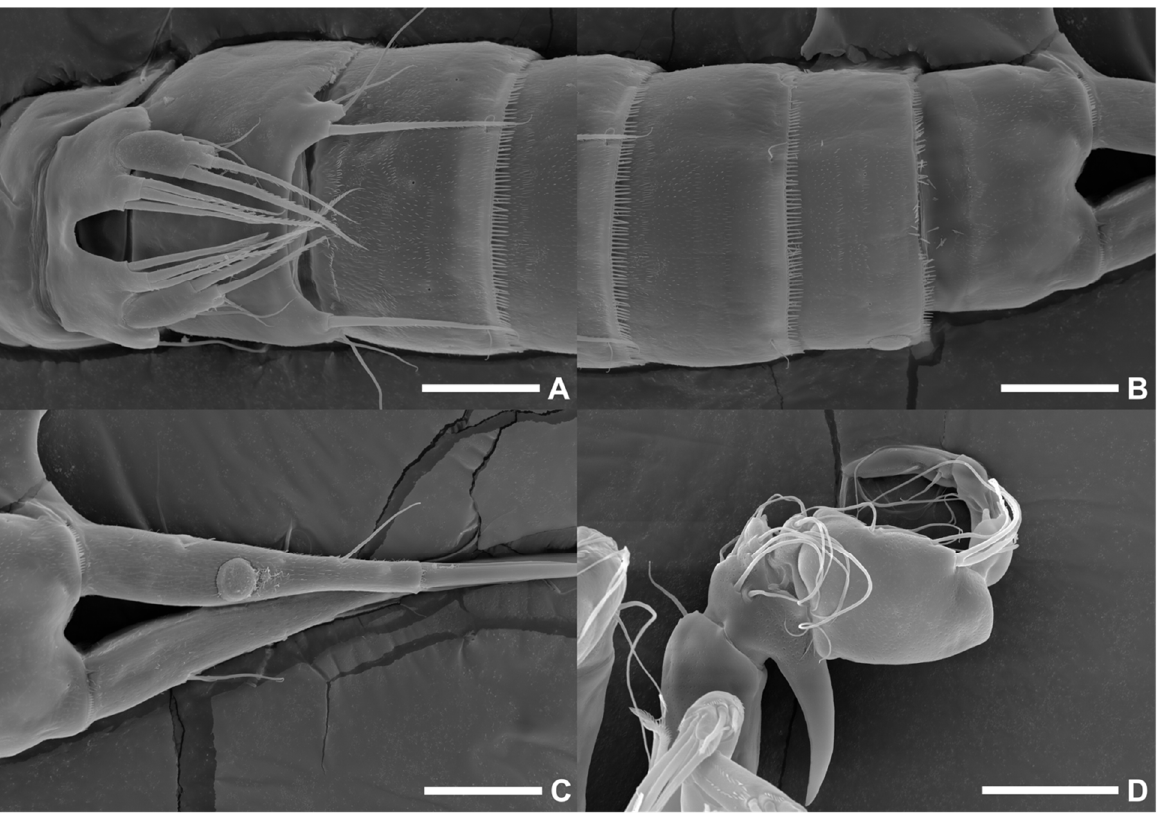
Figure 16. Scanning electron microscopy images of Phyllopodopsyllus saywakimi sp. nov. male (paratype 13) in ventral view: ( A ) second to third urosomites, P5, and P6; ( B ) fourth urosomite to anal somite; ( C ) caudal rami; ( D ) antennule. Scale bars: 30 µ